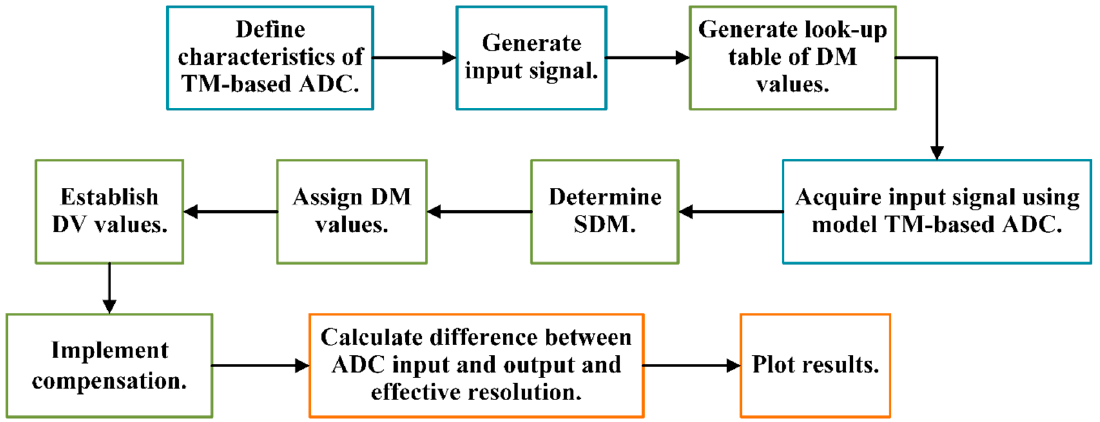
Figure 7. Flow diagram of MATLAB script developed to test the algorithm.